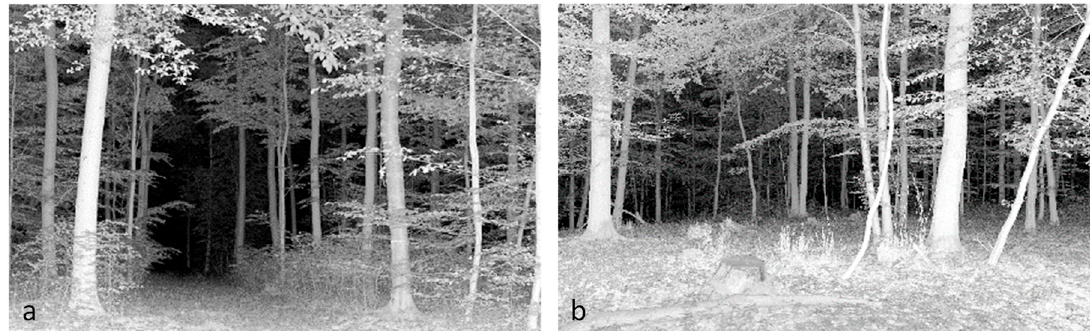
Figure 3. Exemplary locations of measurements on skid-trails ( a ) and away from skid-trails ( b ).